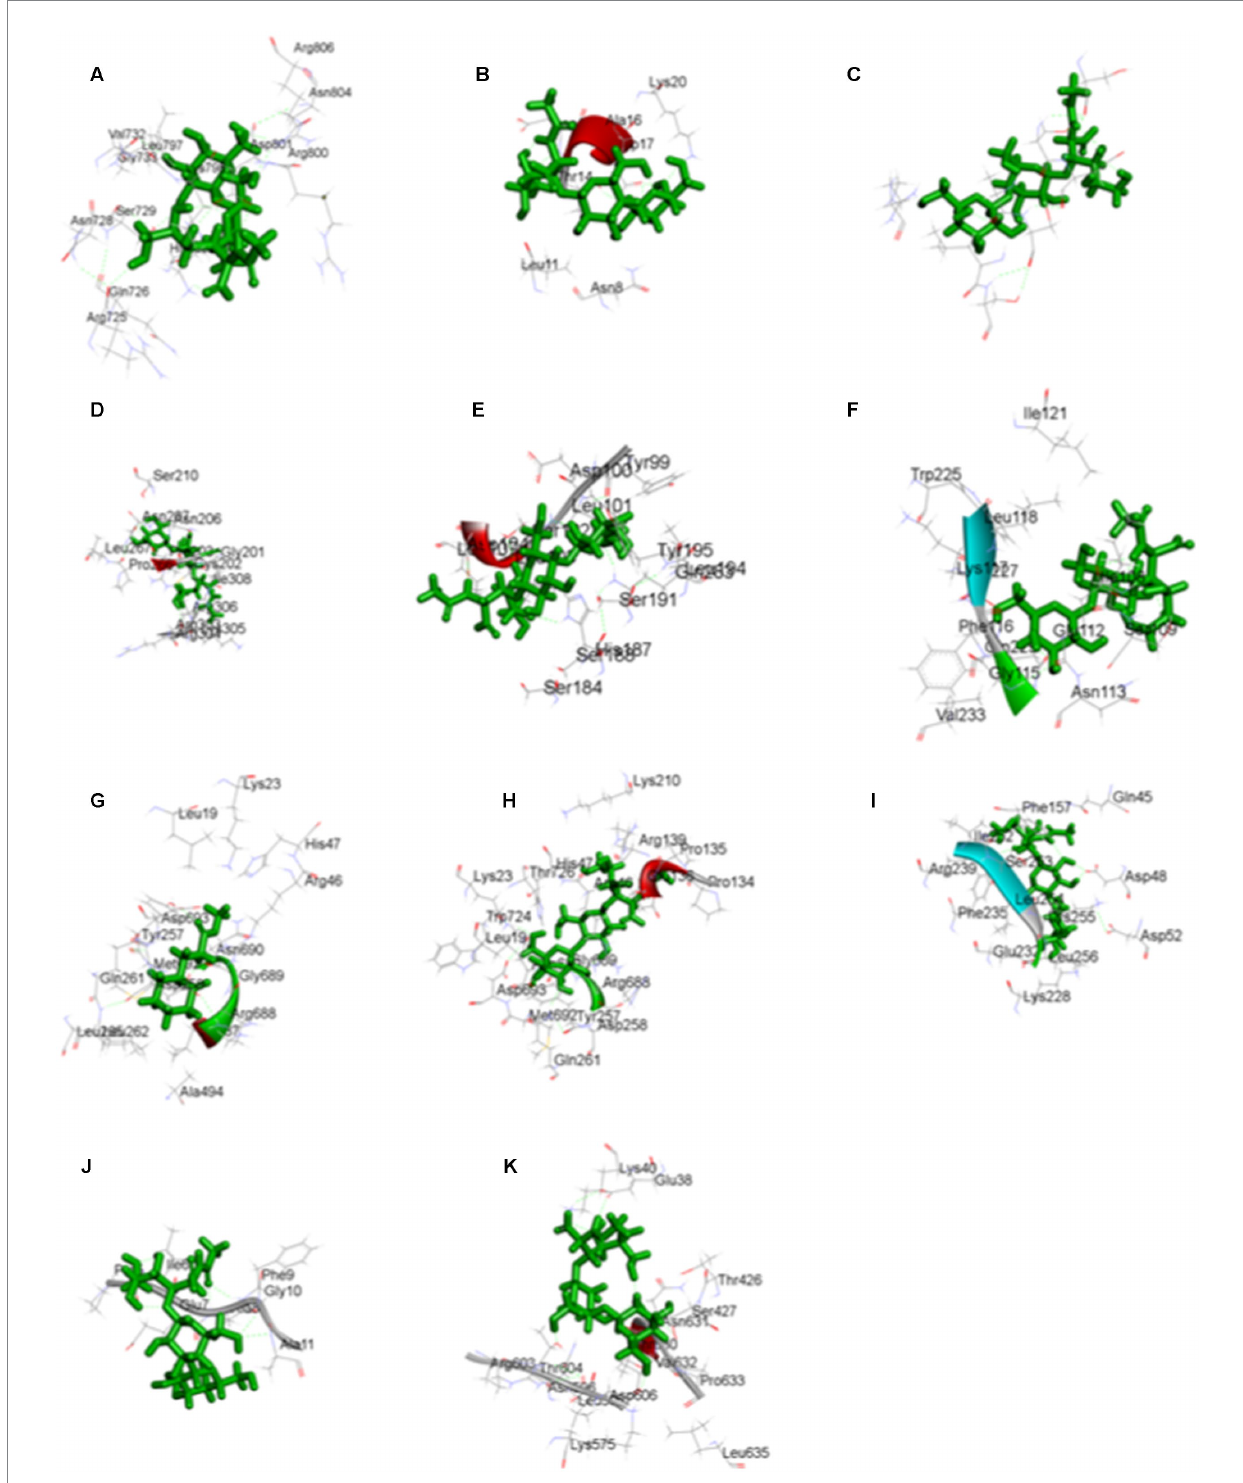
FIGURE 11 The three-dimensional interaction map of 3-o-(4-o-Beta-D-Galactopyranosyl-Beta-D-Galactopyraosyl) 2-Acetylamino-2-Deoxy-D-Galactose against (A) calcium binding protein, (B) Cellulose synthase, (C) Delta DNA Polymerase, (D) GATA Transcription factor, (E) hypothetical protein, (F) Nucleoside diphosphate kinase, (H) Phenylalanine ammonia lyase, (I) Protein kinase, (J) Ribulose biphosphate carboxylase, (K) SRP, and Cyclohexanepropanoic acid, 2-oxo-, methyl ester (CAS) with (G) Phenylalanine ammonia